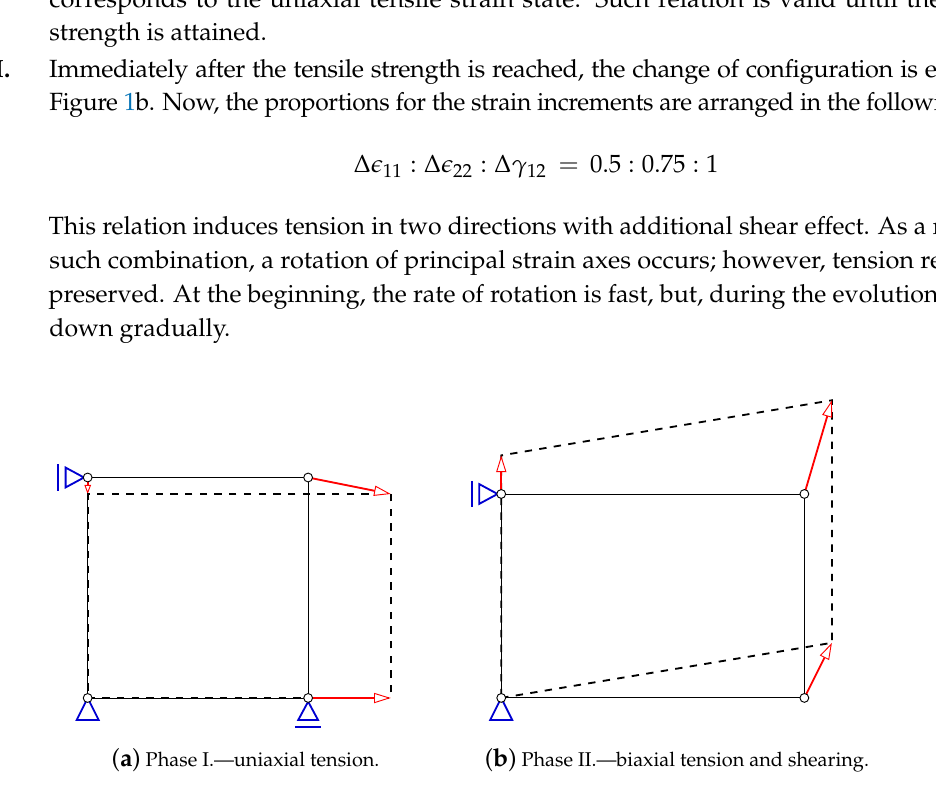
Figure 1. Prescribed displacements for the corresponding strain state in Willam’s